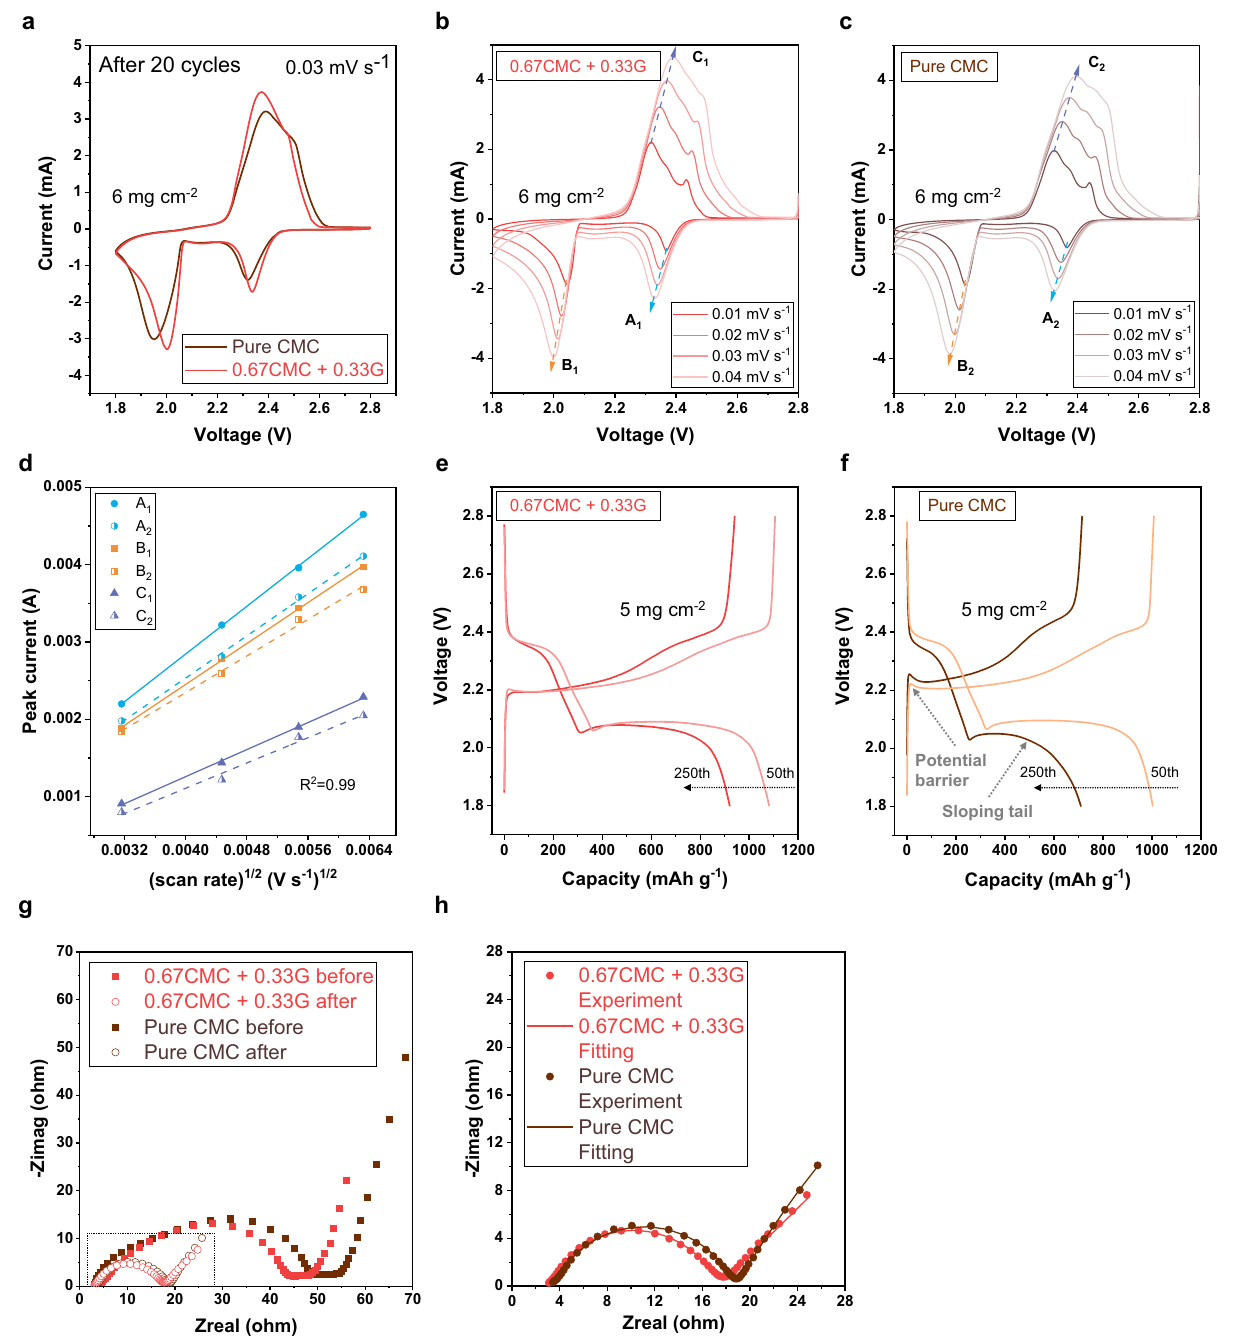
Fig. 7 Electrochemical characterisation on sulfur cathodes with two different binder systems. Cyclic voltammogram pro fi les. a CV pro fi les comparison; CV pro fi les at different scan rates of lithium-sulfur cells with b CMC/G cathode and c CMC cathode; d the linear fi ts ( R 2 = 0.99) of the CV peak currents for the lithium-sulfur cells with CMC/G cathode (A 1 , B 1 , C 1 ) and with CMC cathode (A 2 , B 2 , C 2 ). Charge/discharge pro fi les corresponding of lithium-sulfur cells with e CMC/G cathode and f CMC cathode. Electrochemical impedance spectroscopy g Nyquist plots of the lithium-sulfur cells with CMC/G and CMC cathodes before and after 80 cycles; h Nyquist plot and equivalent circuit fi tting of cells after